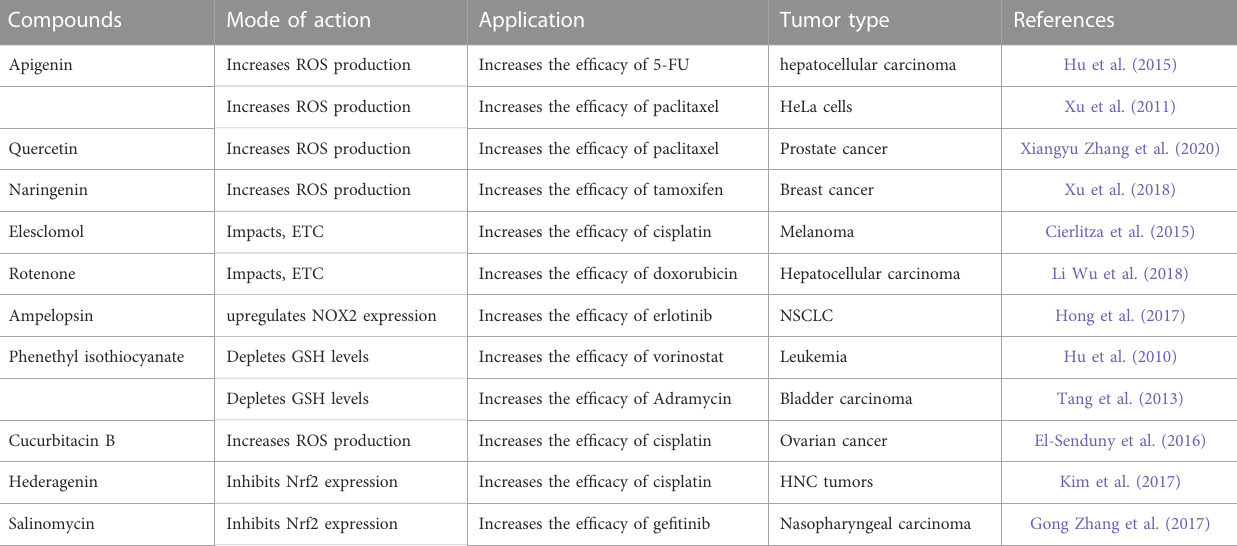
TABLE 3 Summary of compounds that enhance the ef fi cacy of classical chemotherapeutic drugs.